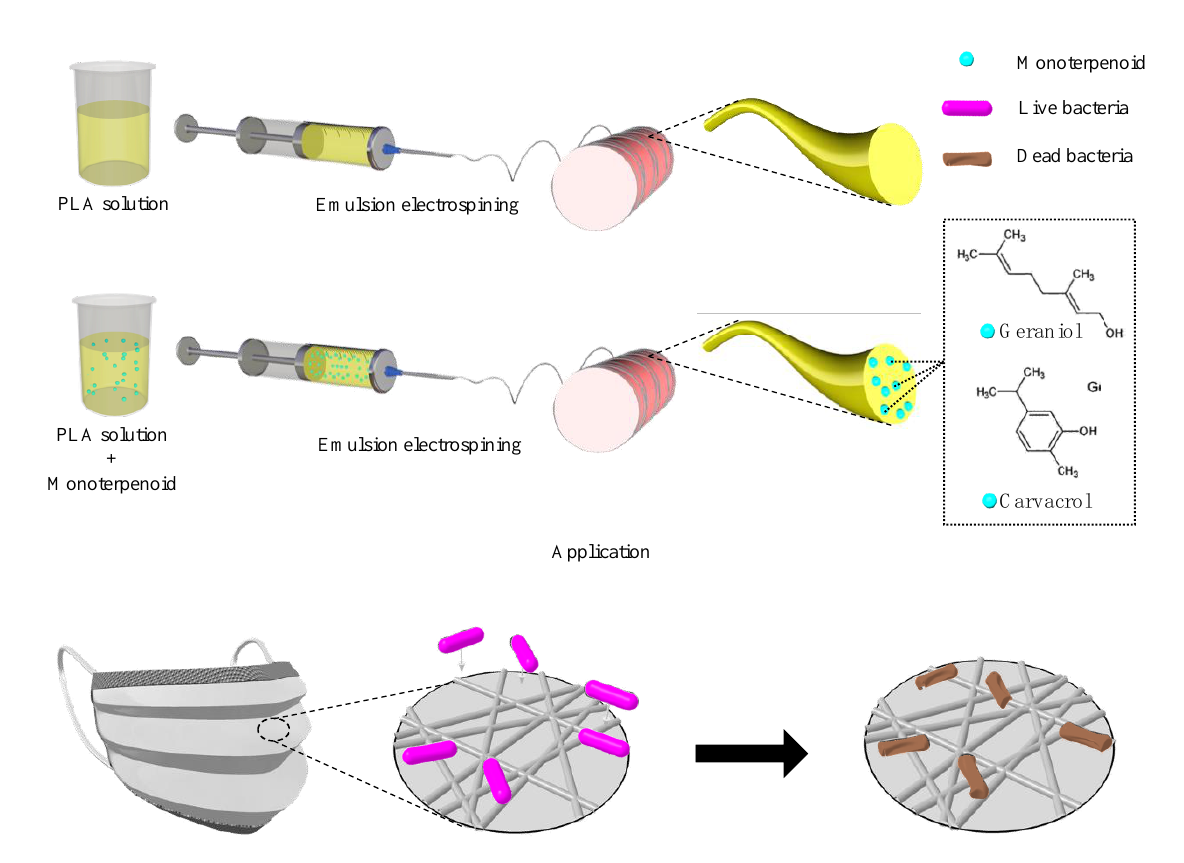
Figure 1. Schematic illustration of the emulsion electrospinning procedure.